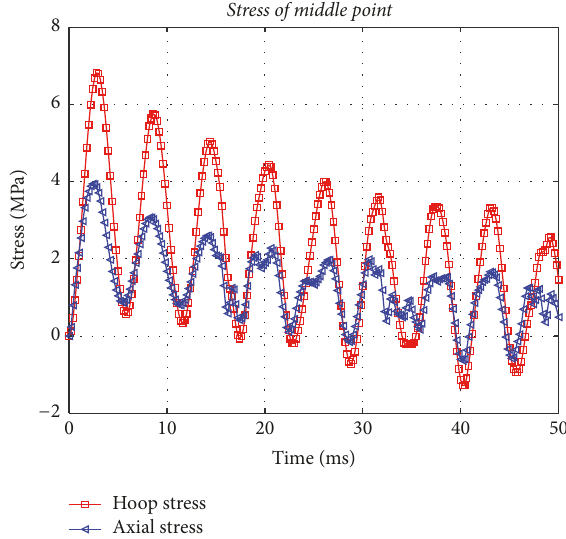
Figure 4: Maximum hoop stress and axial stress of shell’s centre point.